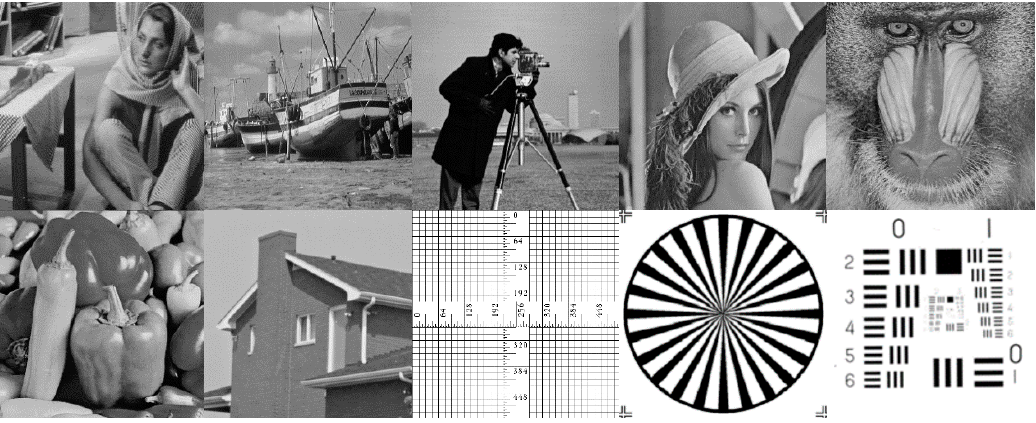
Figure 1. Test images.